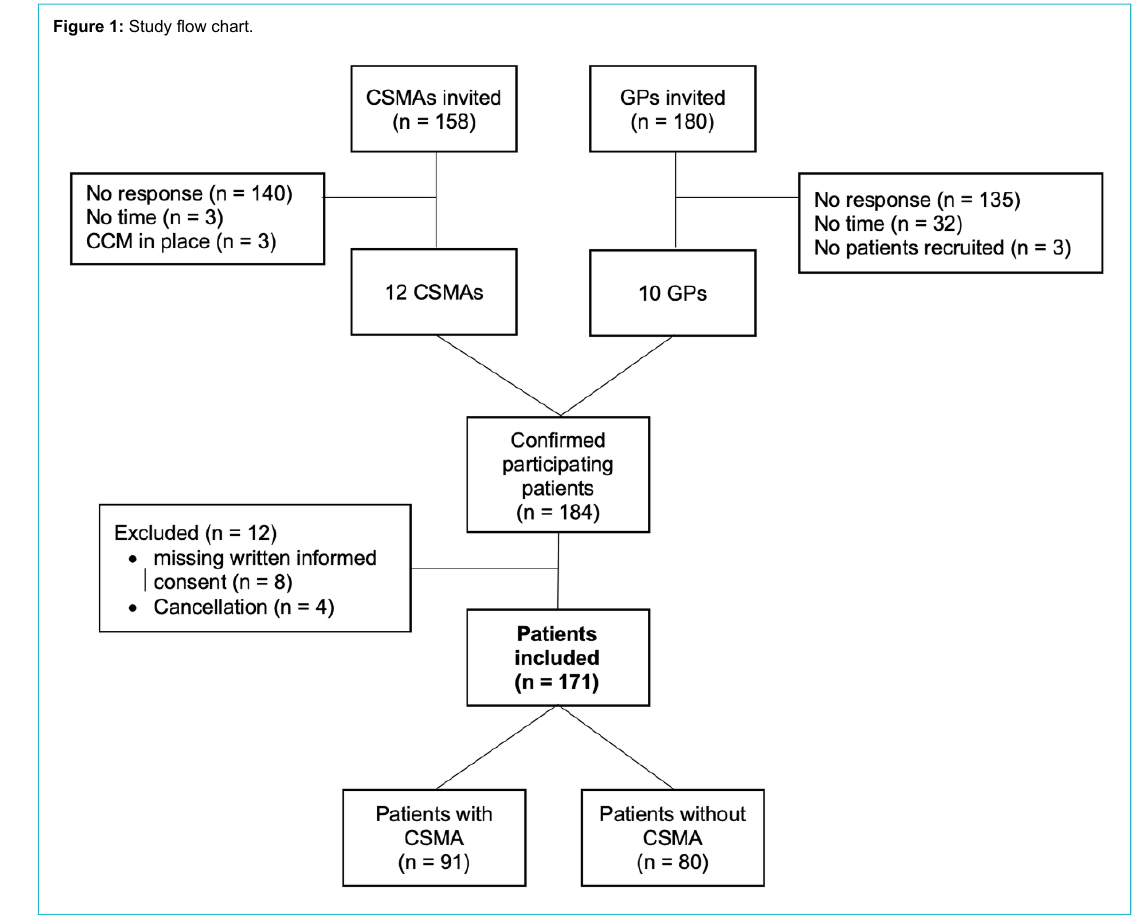
Figure 1: Study flow